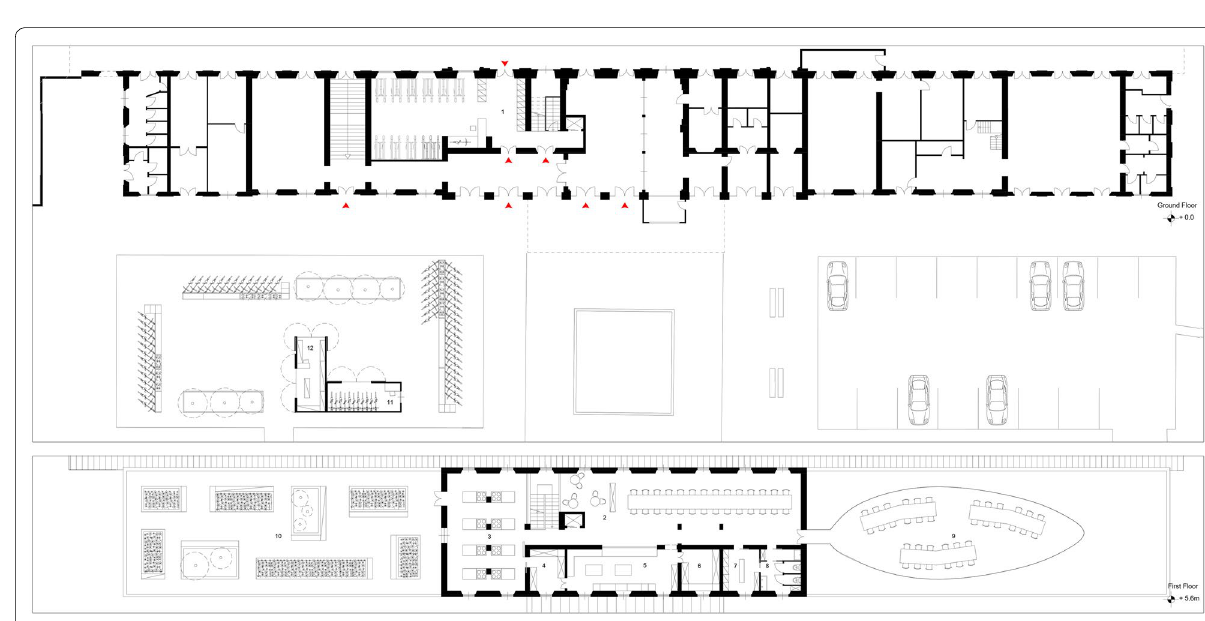
Fig. 10 Plans with internal redesign of Tortona station. [Scale